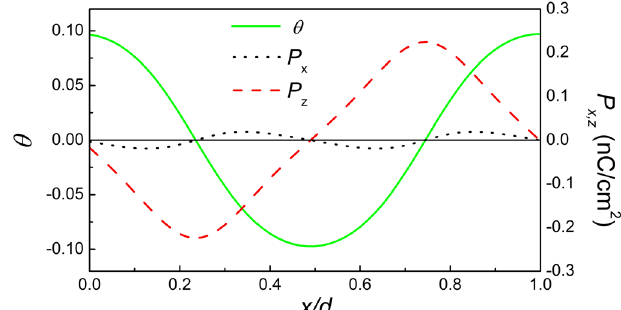
. The sample size is varied c